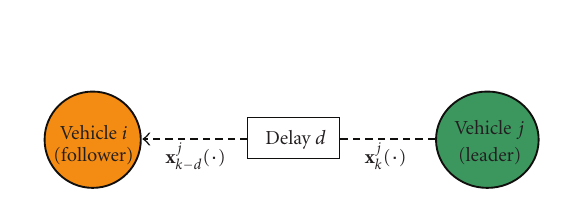
Algorithm 1: Delay-free DMPC.